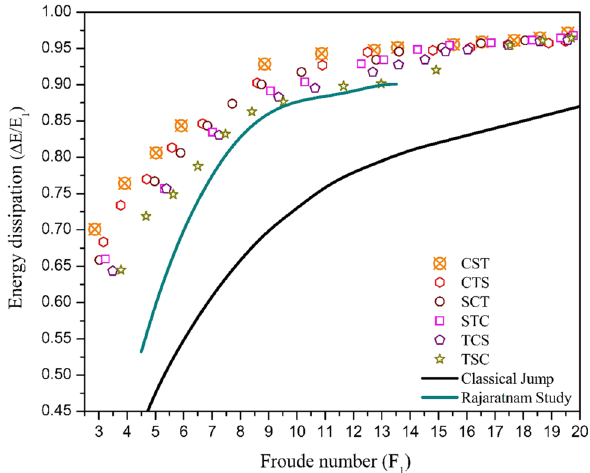
Fig. 6 Relative energy loss, ∆ E/E